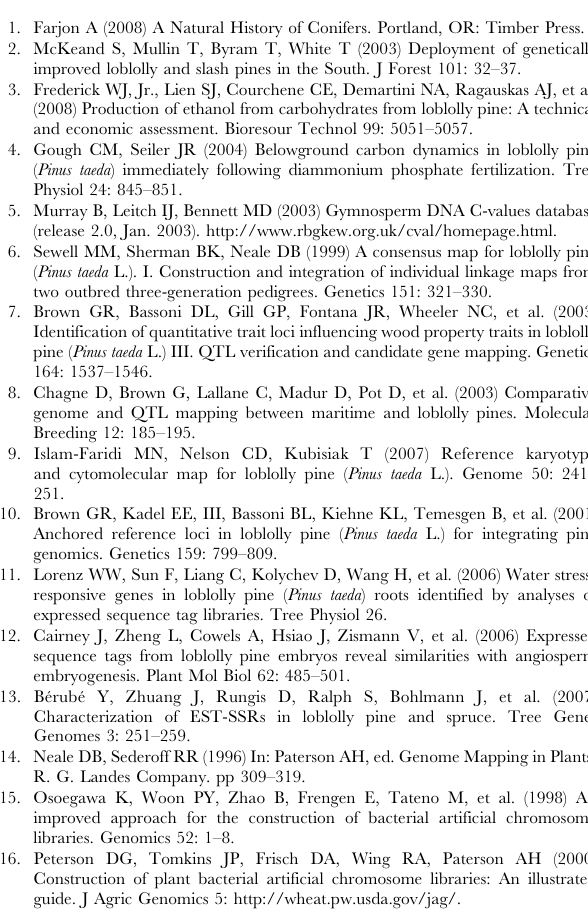
Figure S2 The LP LEA protein shows similarity to the LEA 3 family of proteins (pfam03242). Table S1 Additional Methods. Table S2 Calculating the copy number and genome percentage of IFG-7 based on densitometric analysis of a macroarray. Based on Peterson et al. [42] Supplementary Documents. Aqua shaded cells contain data generated in the current study. Violet shaded cells contain data from the